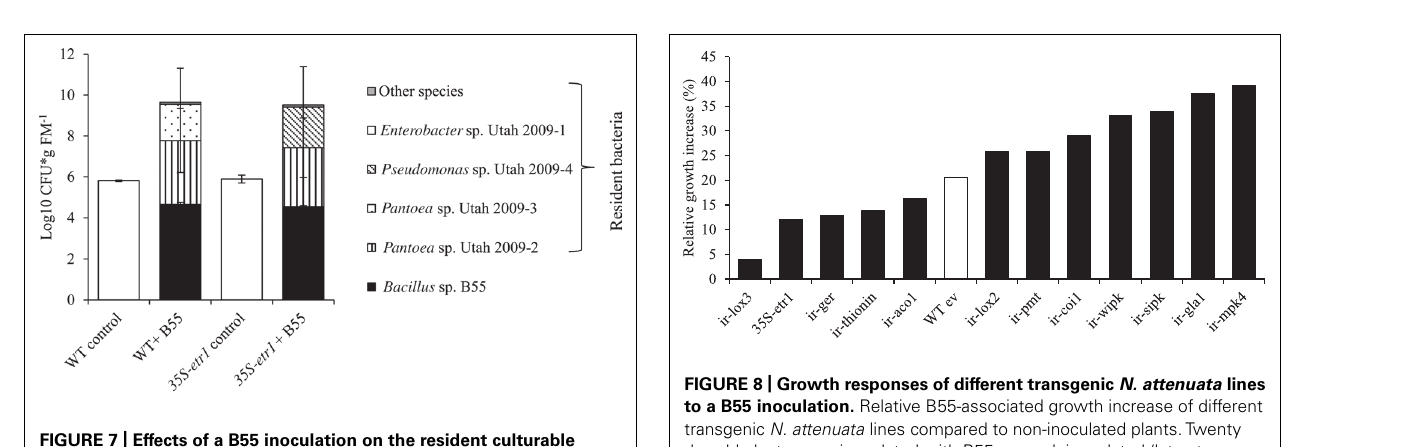
FIGURE 6 | Effects of a B55 inoculation on field-grownWT plants (field season 2010). Mean ( ± SE) rosette diameter and stalk height of B55-inoculated and mock-inoculated plants. Plants were grown in a paired design. Only pairs in which both plants survived